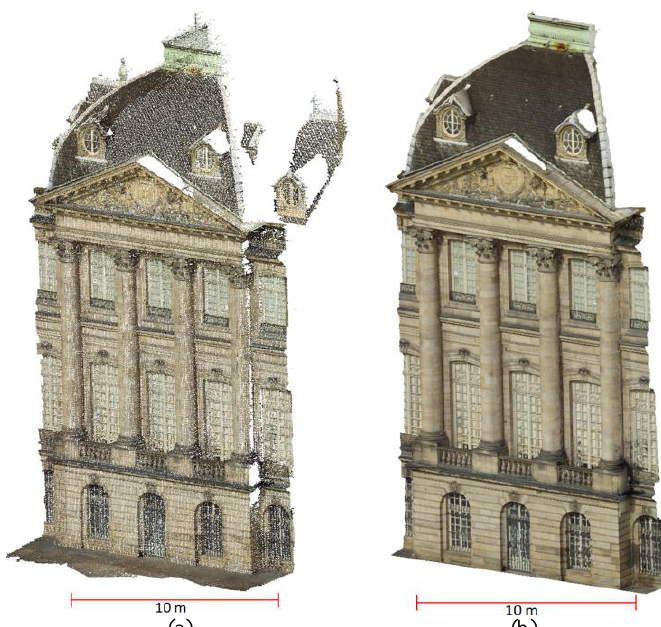
Figure 2. Results of the dense matching (a) and the meshed and textured model (b) of the Rohan dataset.